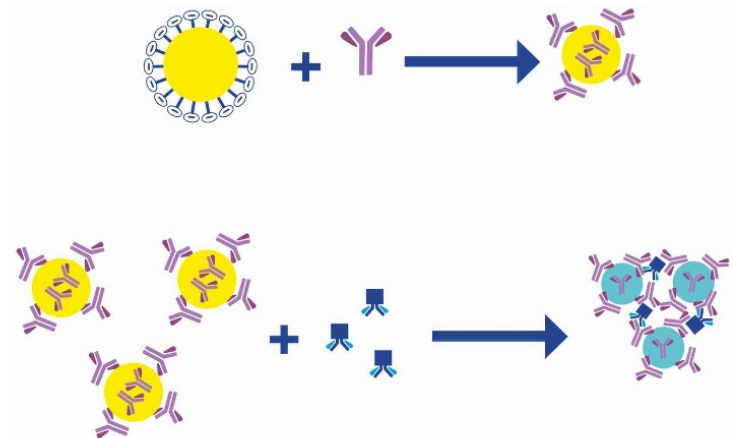
Fig 1. A schematic diagram of experimental procedure. ( ) citrate capped AuNPs, ( ) antibody, ( )antigen.